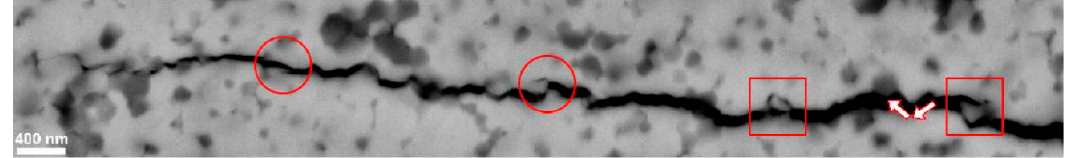
Figure 6. SEM micrograph showing an arrested crack propagated from the Vickers indent. Circles, squares, and arrows indicate the crack branching, crack bridging, and crack deflection, respectively.